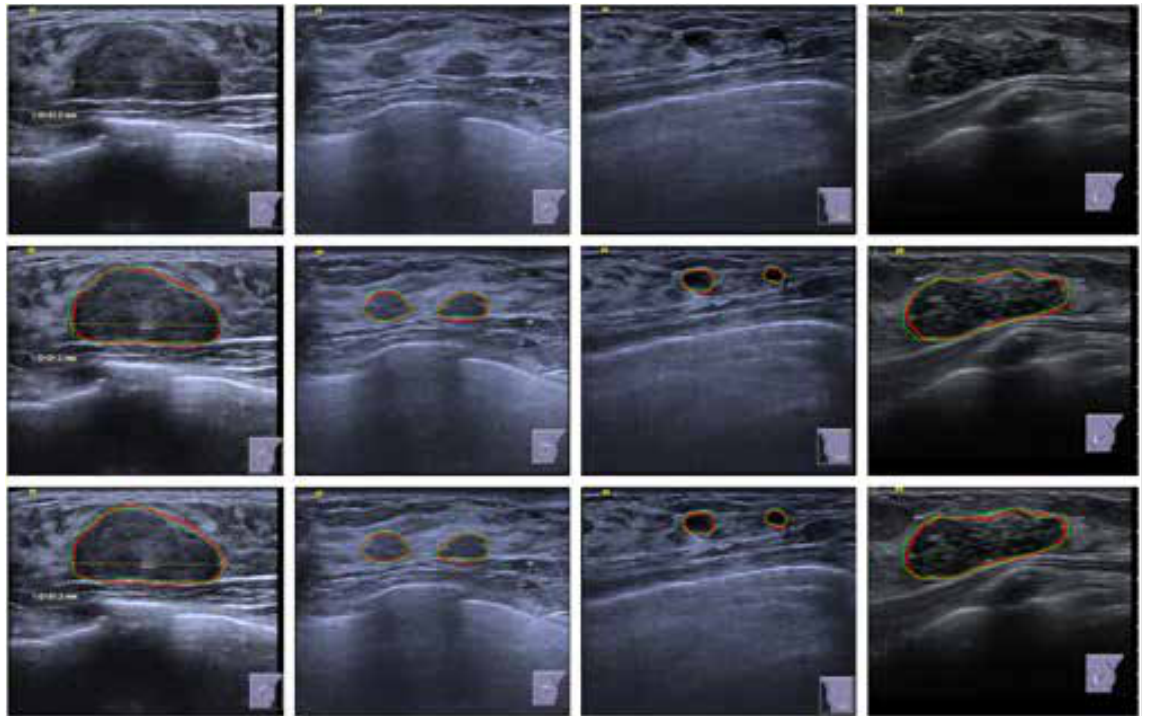
Figure 8 Segmentation cases of breast nodule images by the pre-trained convolutional neural network (PCNN) and convolutional neural network without pre-training (NCNN), respectively. The original images are shown in the first row; the ground truths are green; the segmentation results of the PCNN and the NCNN are red shown in the second row and in the third row,